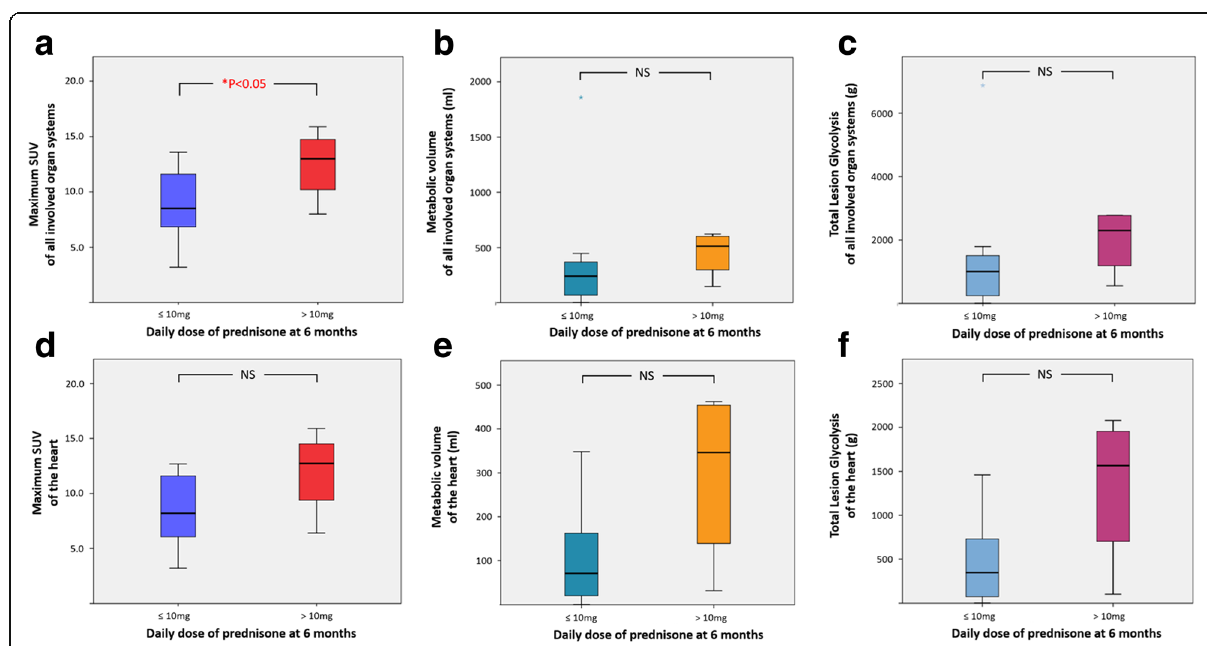
Fig. 4 Box plots of differences in the semi-quantitative values of all involved organ systems including the heart ( a , b , c ) and the heart alone ( d , e , f ) between patients with daily oral steroid dose of less or equal to 10 mg and those with greater than 10 mg. * represents statistically siginificant differ- ence. The central box represents values from lower to upper quartile (25 – 75%), the middle line represents the median, vertical bars extend from 5 to 95%, and asterisks represent outliers